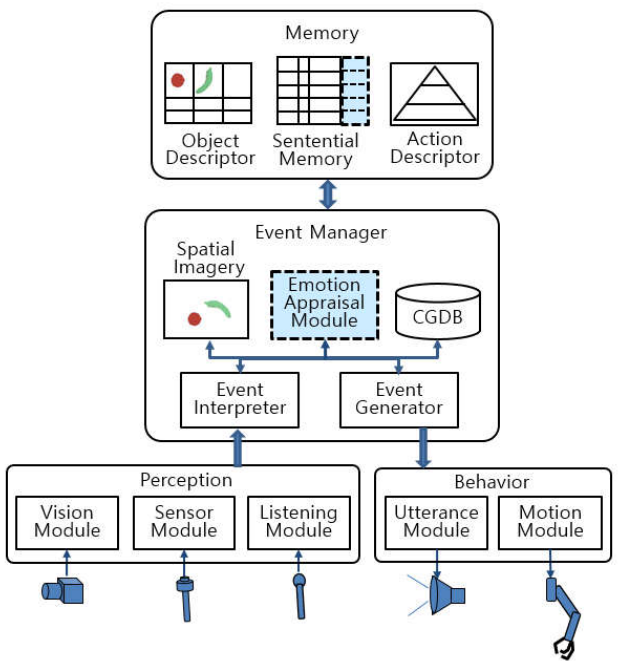
Figure 4. Schematic of an emotion appraisal system based on sentential cognitive system (SCS) that produces modular sentences with emotion valences from all events, and stores them in the sentential and auxiliary memories.